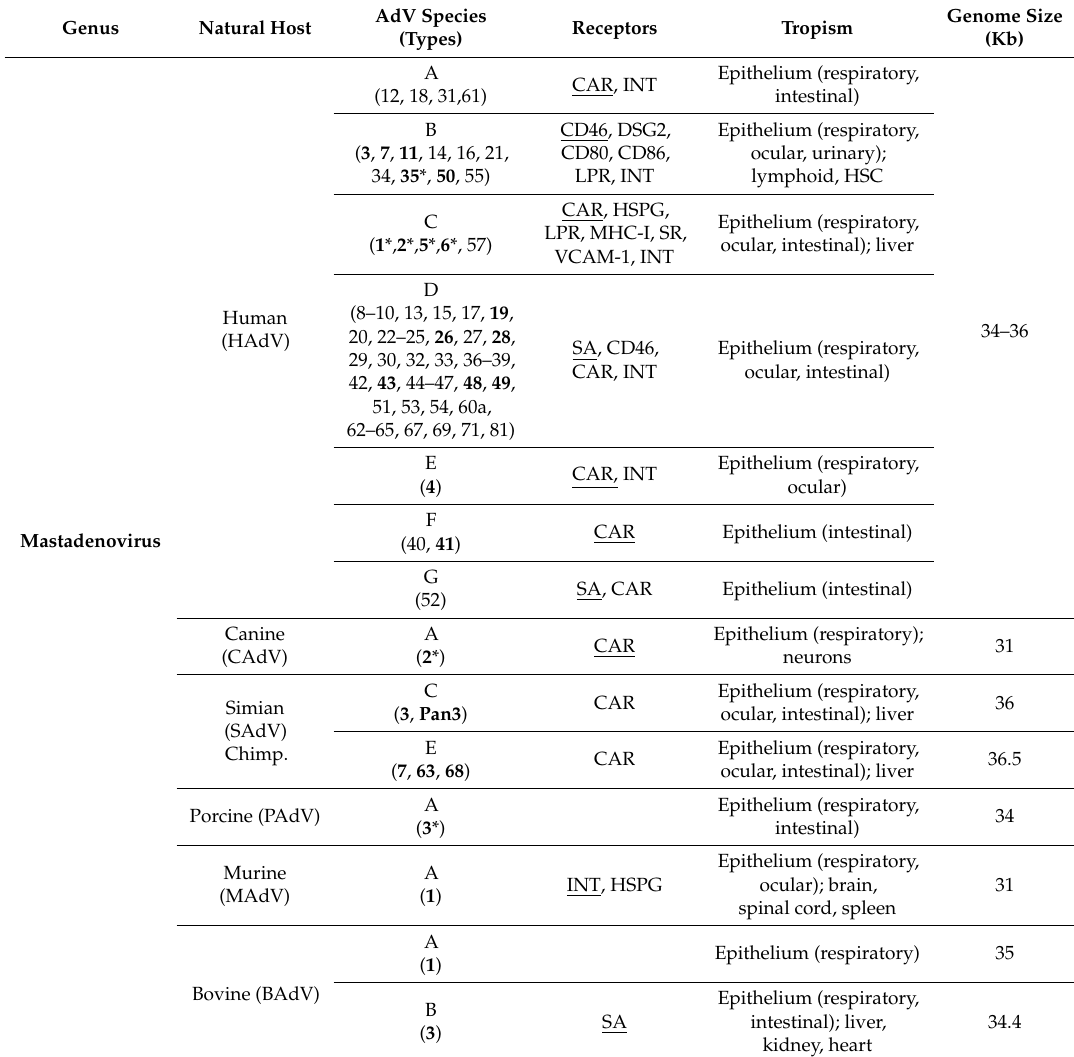
Table 1. Characteristics of all human adenovirus (HAdV) types, and selected examples of animal AdVs adapted as gene therapy